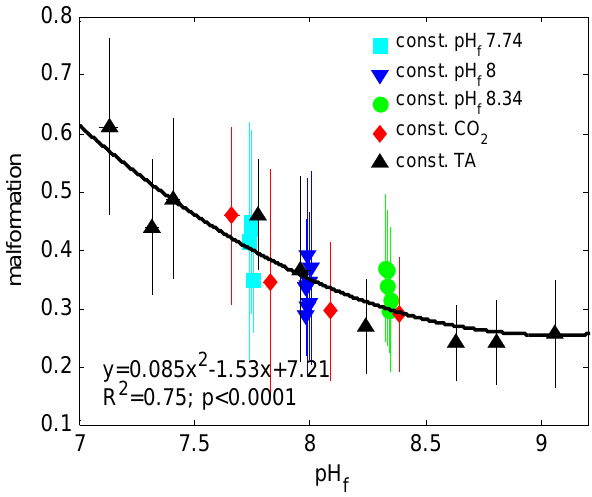
Fig. 4. Malformation of coccoliths calculated with Eq. (8). Error Figure 4. Malformation of coccoliths calculated with eq. 8. Error bars denote the standard bars denote the standard deviation from measured mean malforma- deviation from measured mean malformation of all coccoliths in a treatment. tion of all coccoliths in a